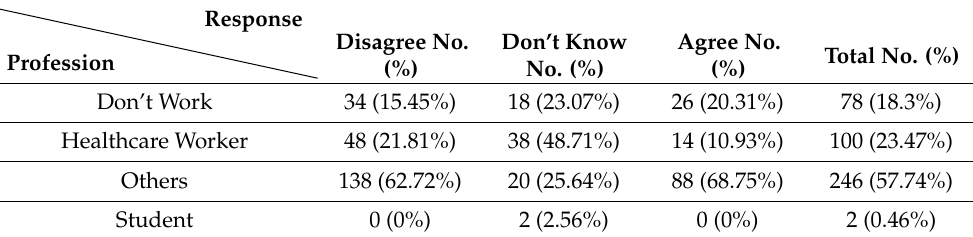
Table 4. Comparison between different professions’ opinions regarding vaccine protection against new variant